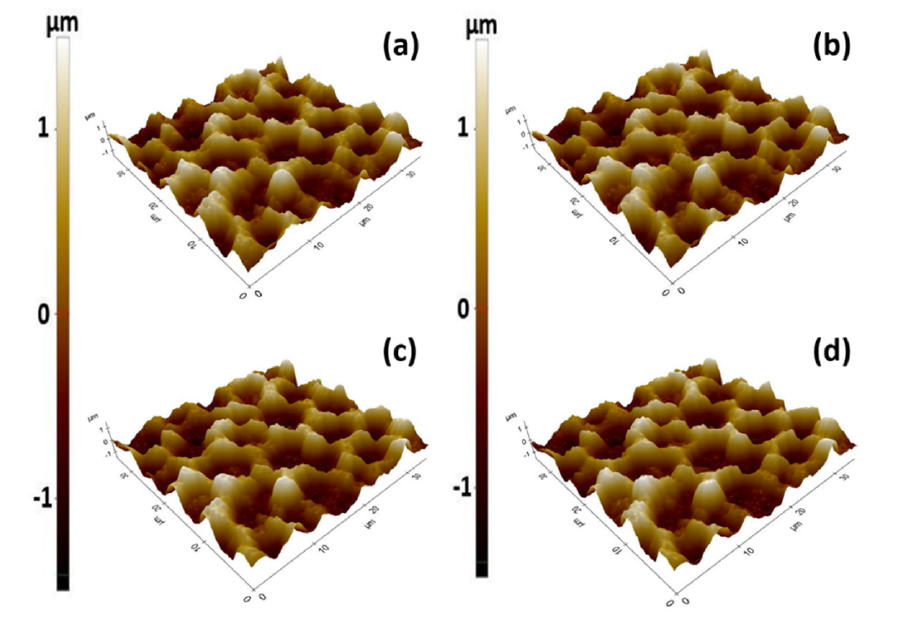
Figure 10. Three–dimensional surface topography image for superhydrophobic nanocomposite coating at ( a ) initial state, ( b ) after 1 min of accelerated corrosion, ( c ) after 3 min of accelerated corrosion, and ( d ) after 60 min of accelerated corrosion.